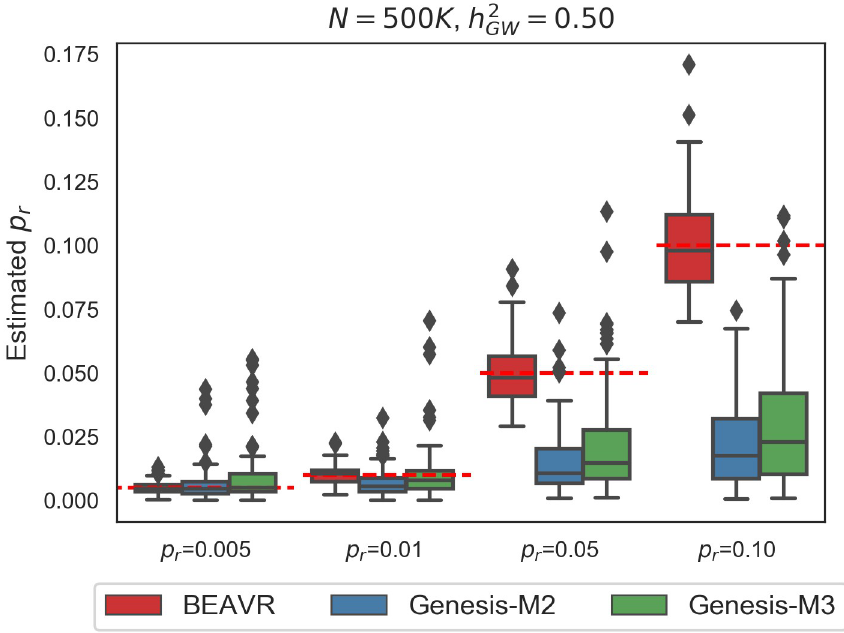
Fig 1. BEAVR is relatively unbiased in simulated data. We ran 100 replicates ( M = 1, 000 SNPs, N = 500K individuals) where the genome-wide heritability was set to h 2 ¼ 0 : 5 and the true polygenicity of the region was p = r GW 0.005, 0.01, 0.05, 0.10. We compared BEAVR to GENESIS-M2 and GENESIS-M3 which employs a spike-and-slab model with either 2 or 3 components (point-mass and either 1 or 2 slabs). All methods are unbiased when the polygenicity is low ( p r = 0.005, 0.01). However, when polygenicity is higher ( p r = 0.05, 0.10), both GENESIS-M2 and GENESIS-M3 are severely downward biased whereas BEAVR provides unbiased estimates across all settings. Dashed red lines denote true regional polygenicity values in each